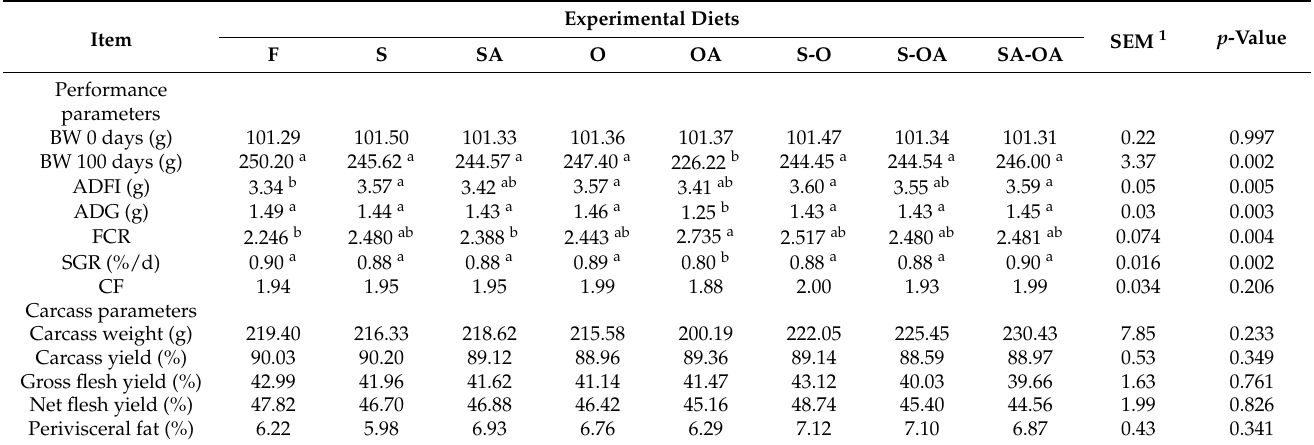
Table 4. Performance, feed efficiency and carcass parameters in European seabass fed different dietary fat sources.